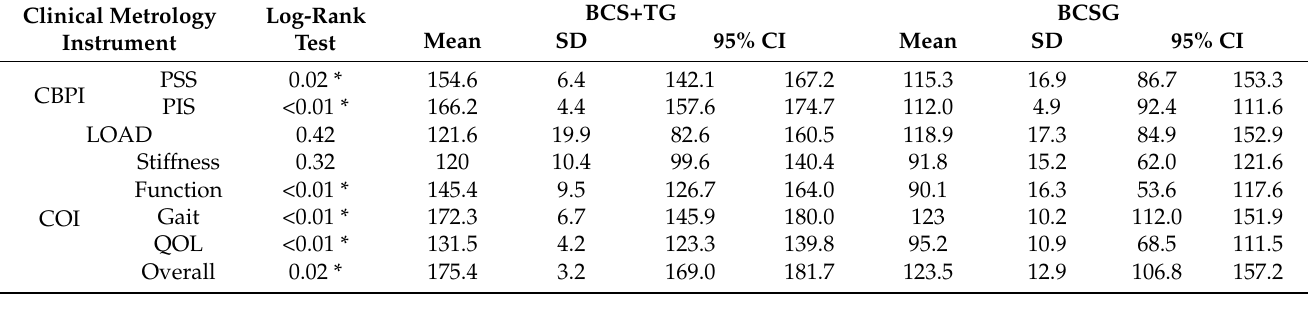
Table 2. Time-to-event (in days) for the clinical metrology instruments considered in the Blood Cell Secretome + triamcinolone group (BCS+TG) and Blood Cell Secretome group (BCSG), calculated with Kaplan–Meier estimators and compared with the logrank test. Events considered were a score change below the improvement level set as clinically significant for each score: ≥ 1 in PSS, ≥ 2 in PIS [33], ≥ 4 in LOAD [34], ≥ 3.5 in COI [34], or when an improved score, compared to baseline values, was no longer observed for stiffness, function gait, and QOL. Legend: CBPI—Canine Brief Pain Inventory;